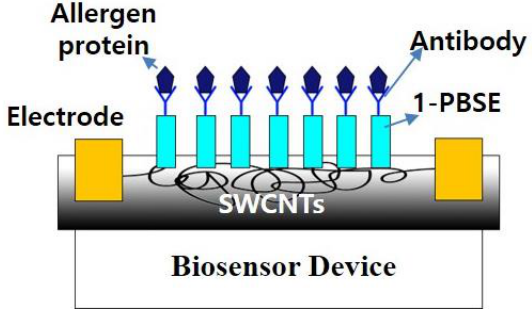
Figure 4. Scheme of SWCNT-based nano-biosensor for the detection of allergen-derived proteins in processed foods [67].